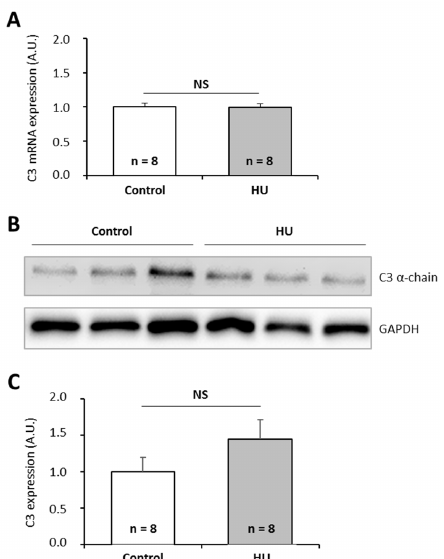
Figure 5. Effects of the hindlimb unloading model, used to simulate microgravity, on murine complement C3 expression. ( A ) C3 mRNAs were quantified by RT-qPCR. ( B, C ) C3 proteins were quantified by western blotting. Western blot results were visualized by chemiluminescence, analyzed by densitometry, and normalized to GAPDH. Relative values obtained with control mice reared under normal housing conditions were set to one in ( A ) and ( C ). Results are expressed as means ± SEM. “A.U.” stands for “arbitrary units”. No differences were found using student’s t -tests. NS., no statistical difference. Int. J. Mol. Sci. 2019 , 20 , x